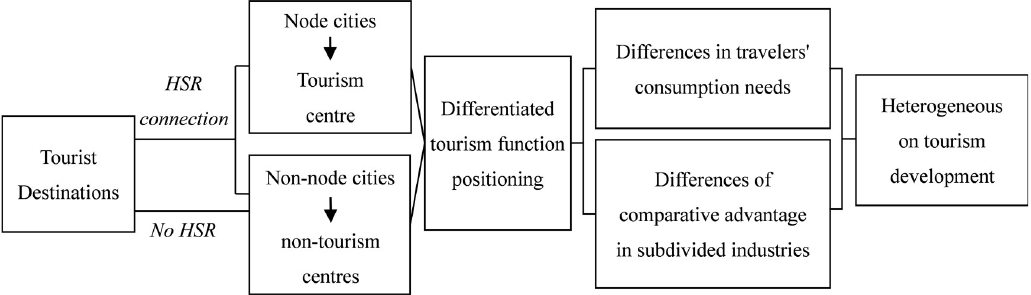
Fig 2. The logical framework of the impact of HSR on urban tourism